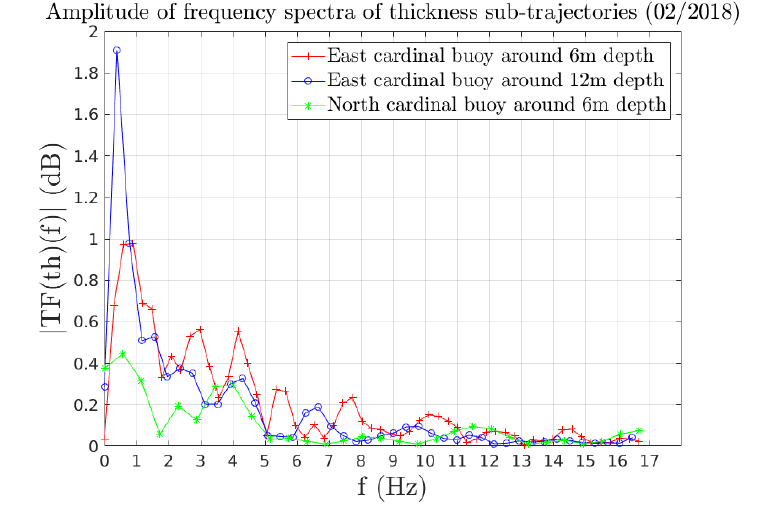
Figure 7. Frequency spectra calculated using an FFT